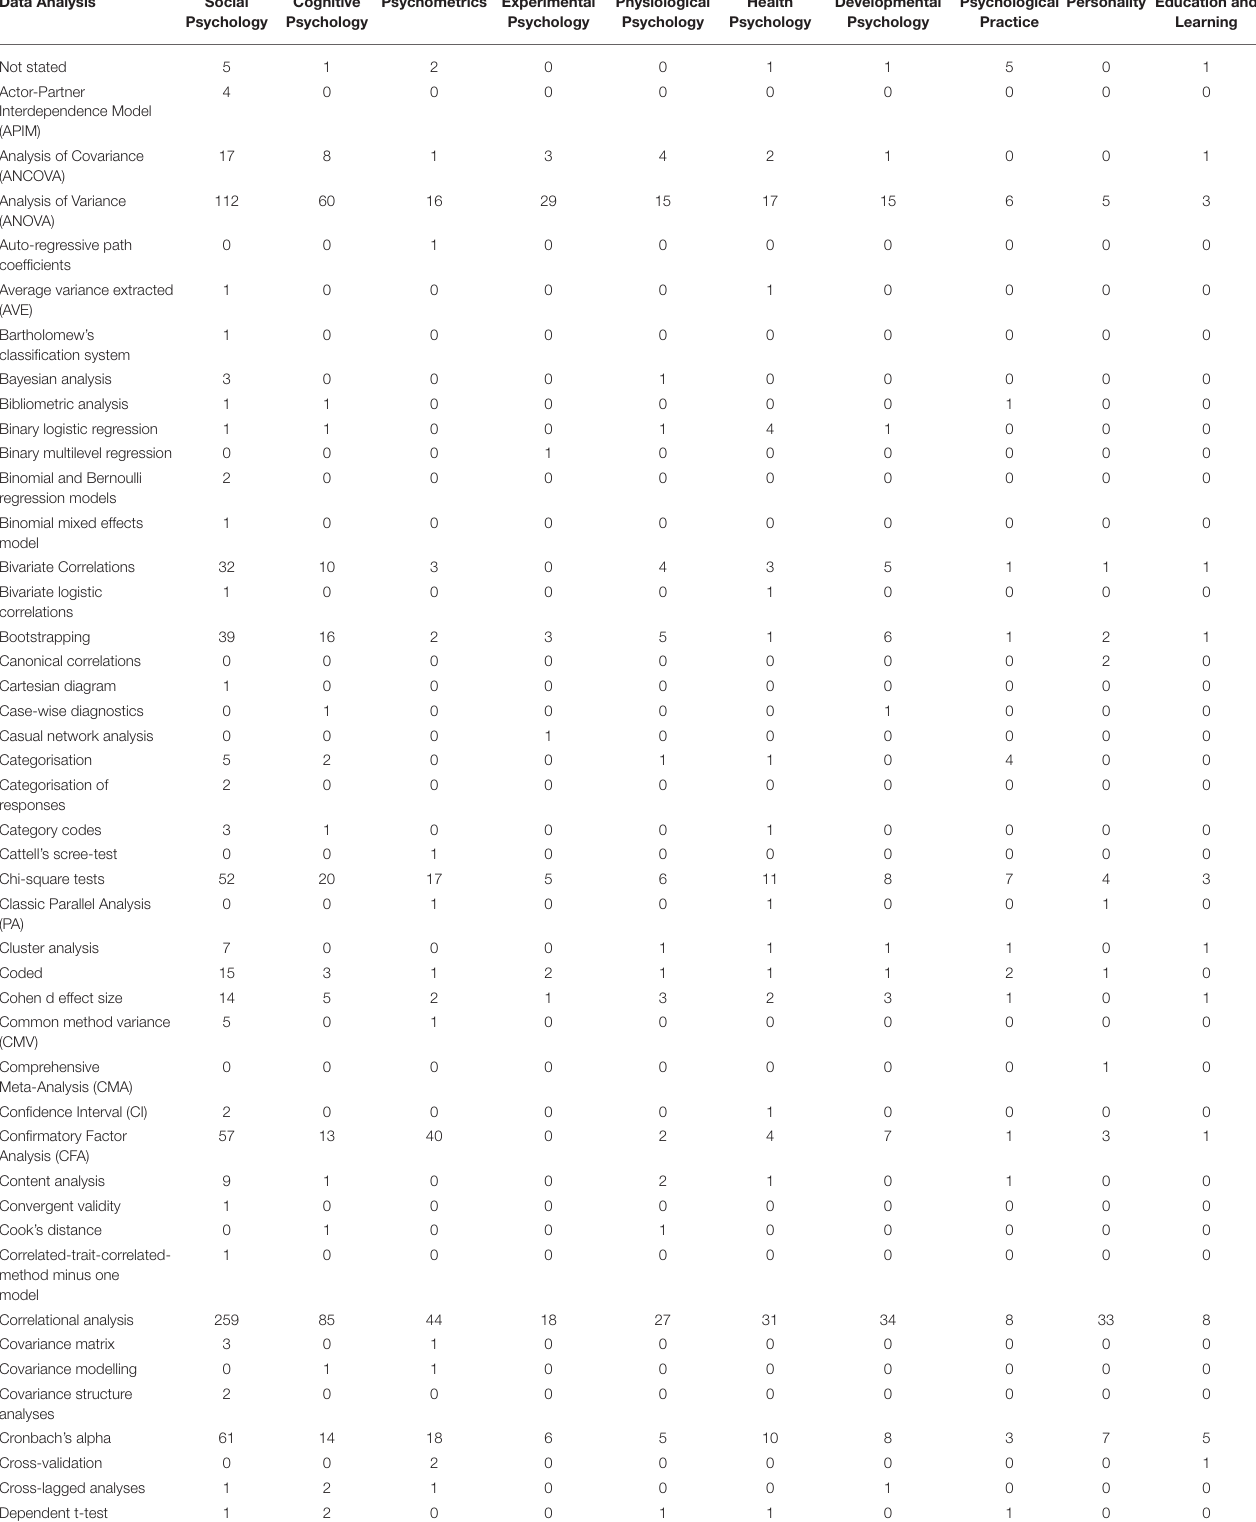
TABLE 6 | Data analysis in the field of